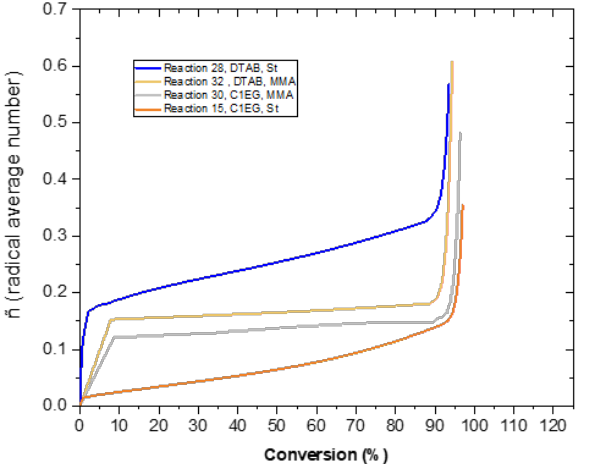
Figure 5. Evolution of the average number of radicals in polymer particles ( n ) with monomer conversion calculated by simulation (POLYRED) for four selected EPs: E15, E28, E30, and E32. The experimental formulation used in the EPs is summarized in Table 1, whereas the parameters used in the simulations are displayed in Table S7 in the SI.